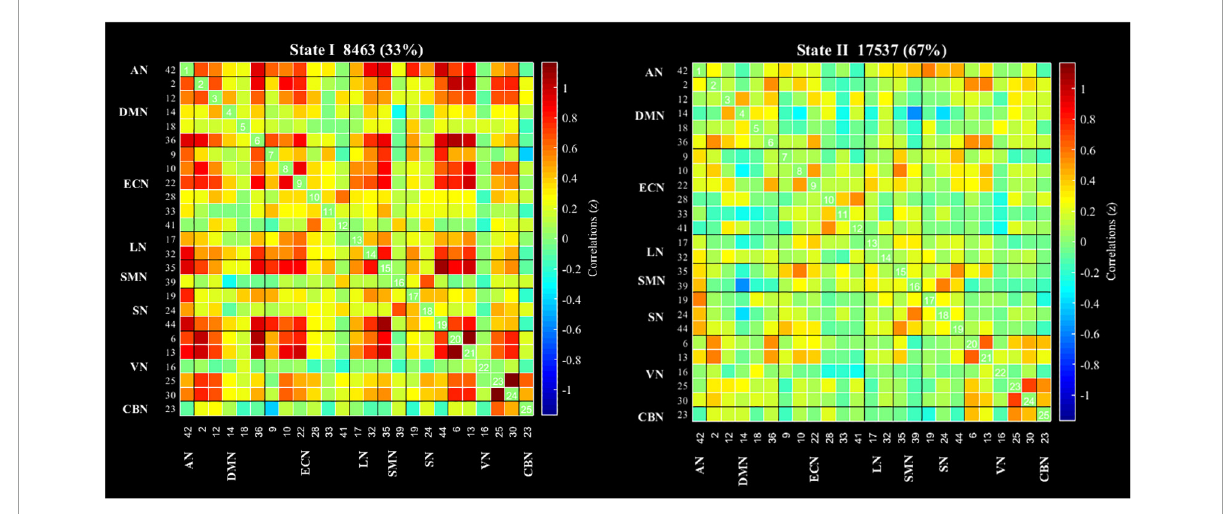
FIGURE3 Results of the clustering analysis per state. Cluster centroids for each state of all participant. The total number of occurrences and percentage of total occurrences are listed in each cluster. AN, auditory network; DMN, default mode network; ECN, executive control network; LN, language network; SMN, sensorimotor network; SN, salience network; VN, visual network; CBN, cerebellar